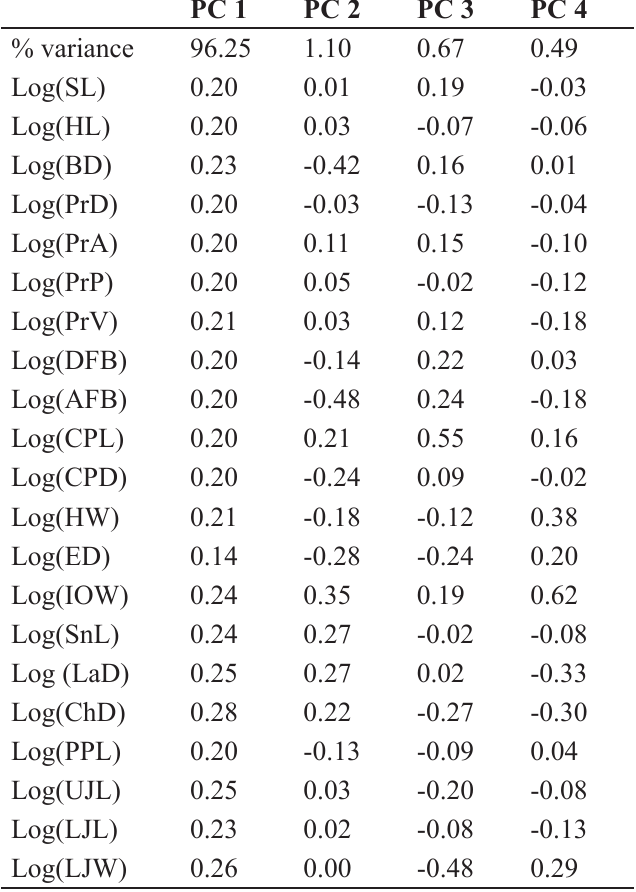
Table S1. PCA loadings of 21 log-transformed measurements from: H . latifrons sp. nov., H . mentatus